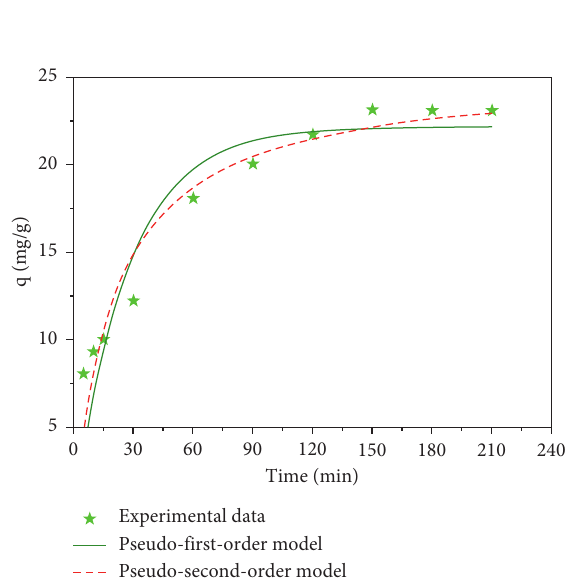
2 O 4 200, and CAC/